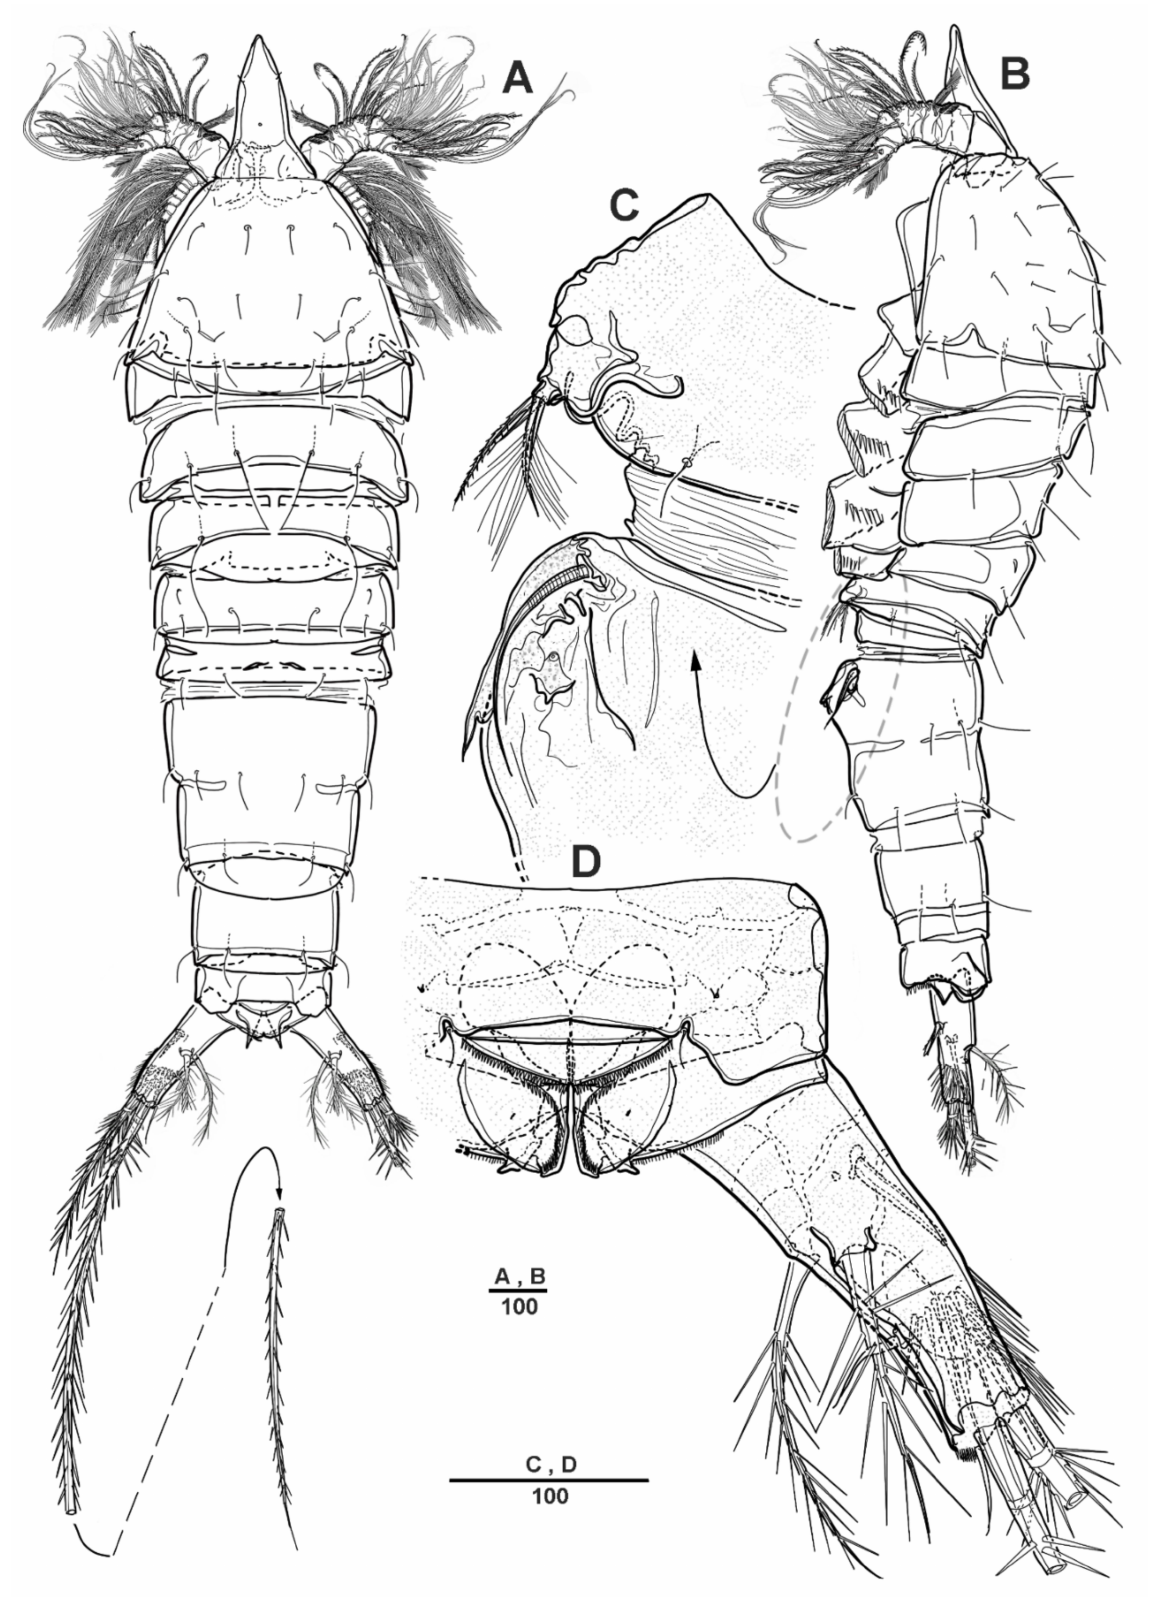
Figure 1. Scottolana daecheonensis sp. nov. holotype female: ( A ) habitus, dorsal; ( B ) habitus, lateral; ( C ) P5 and genital field, lateral; ( D ) anal somite and right caudal ramus, dorsal. Scale bars in µ